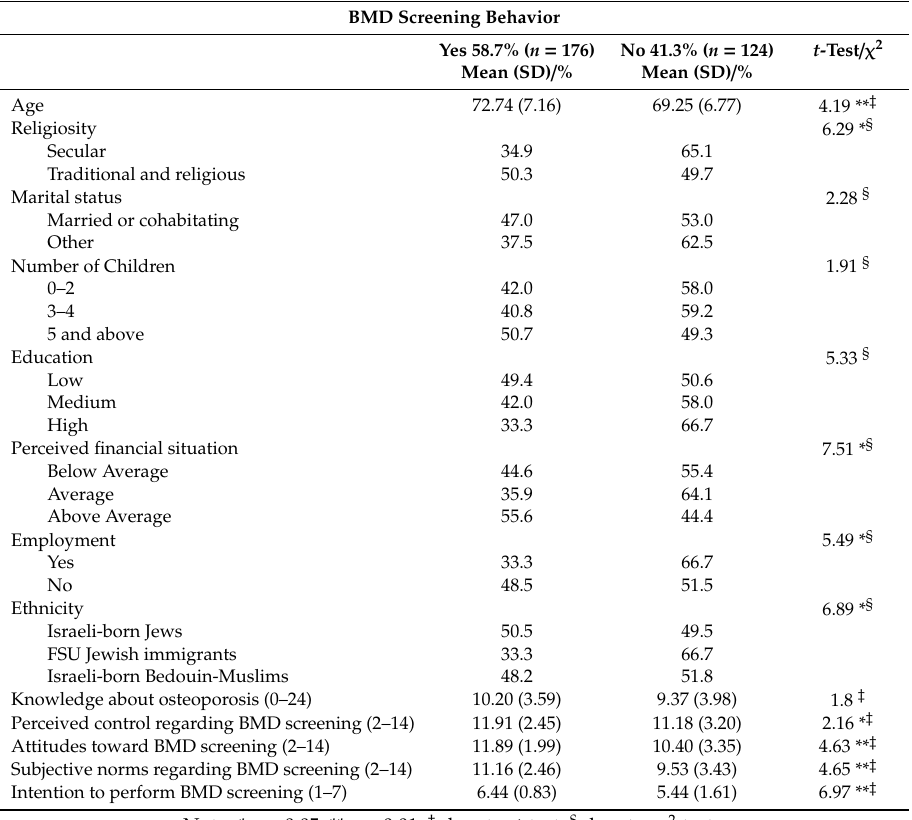
Table 3. Bivariate analysis of the study variables by BMD screening behavior ( n =